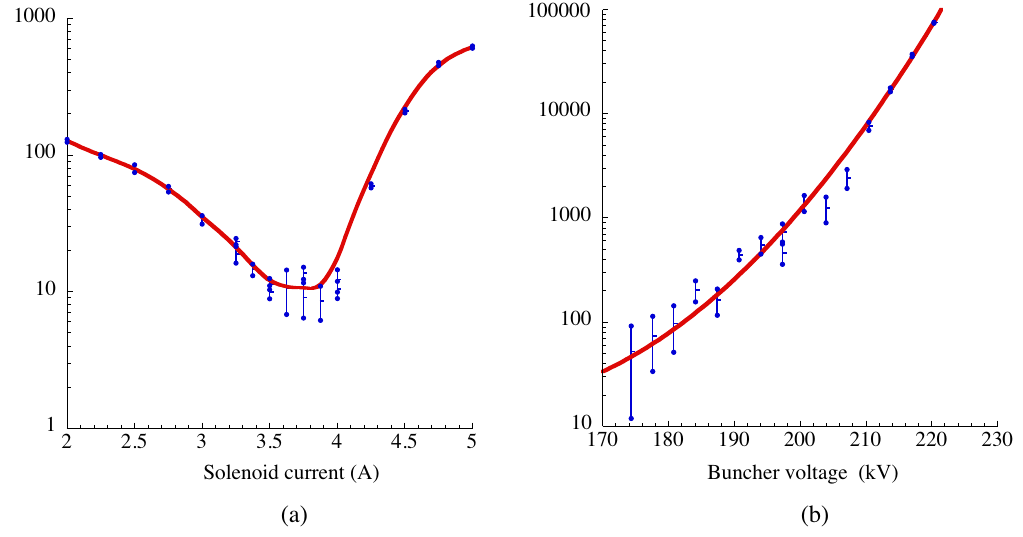
FIG. 19. Dependences of the IR radiation power from the 14.6-MeVelectron beam with a 1.5-nC bunch charge as a function of (a) the current in one of the LEBT solenoids; (b) the voltage of the 500-MHz bunching cavities. Vertical axes for the radiation power have a logarithmic scale. The red continuous lines are smooth fits of the measured data. The radiation power is in units of the base-line value.